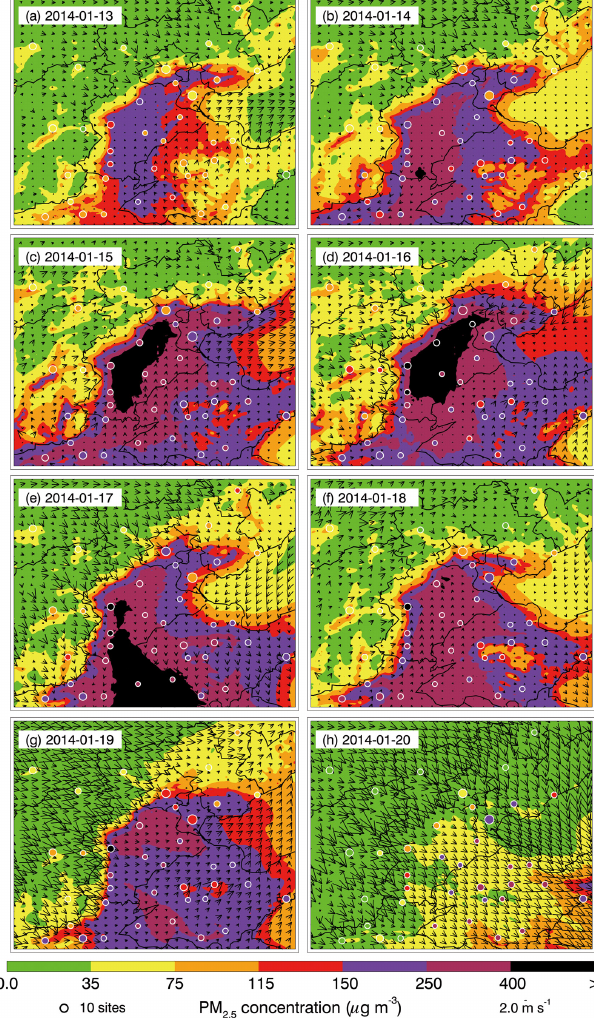
Figure 7. ENSM of the daily average surface PM 2 . 5 concentration distributions (color contour) along with the ENSM of the daily av- erage surface winds (black arrows) from 13 to 20 January 2014. The colored circles denote the PM 2 . 5 measurements in